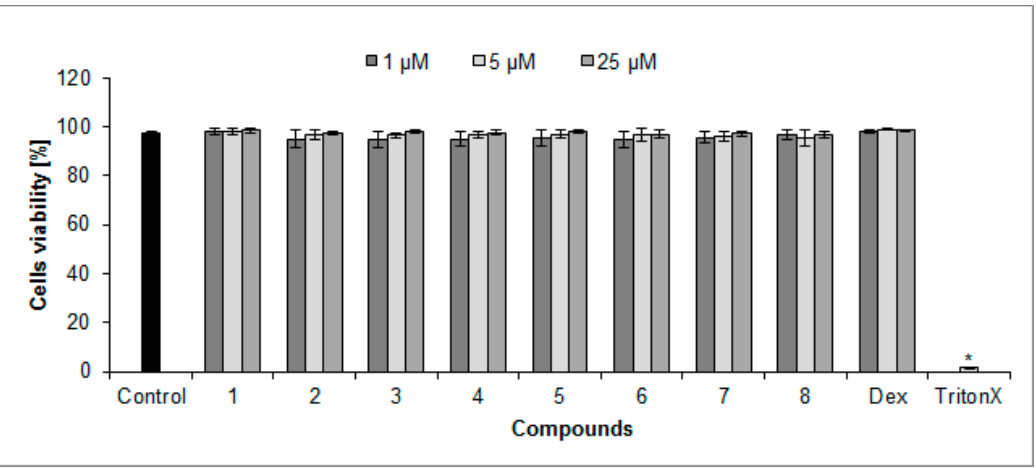
Figure 3. The polymorphonuclear leukocytes (PMNs) viability (%) upon 24 h-treatment with